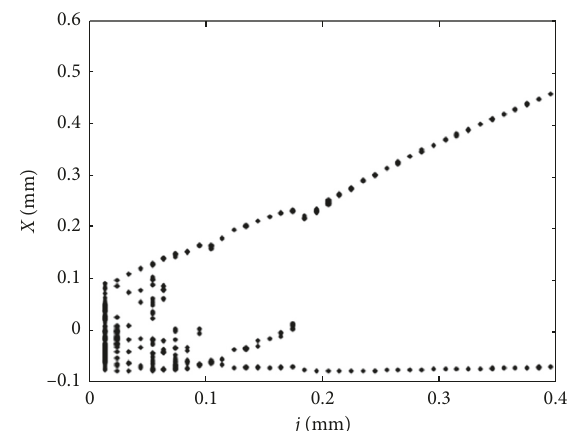
Figure 5: Bifurcation of equivalent displacement.